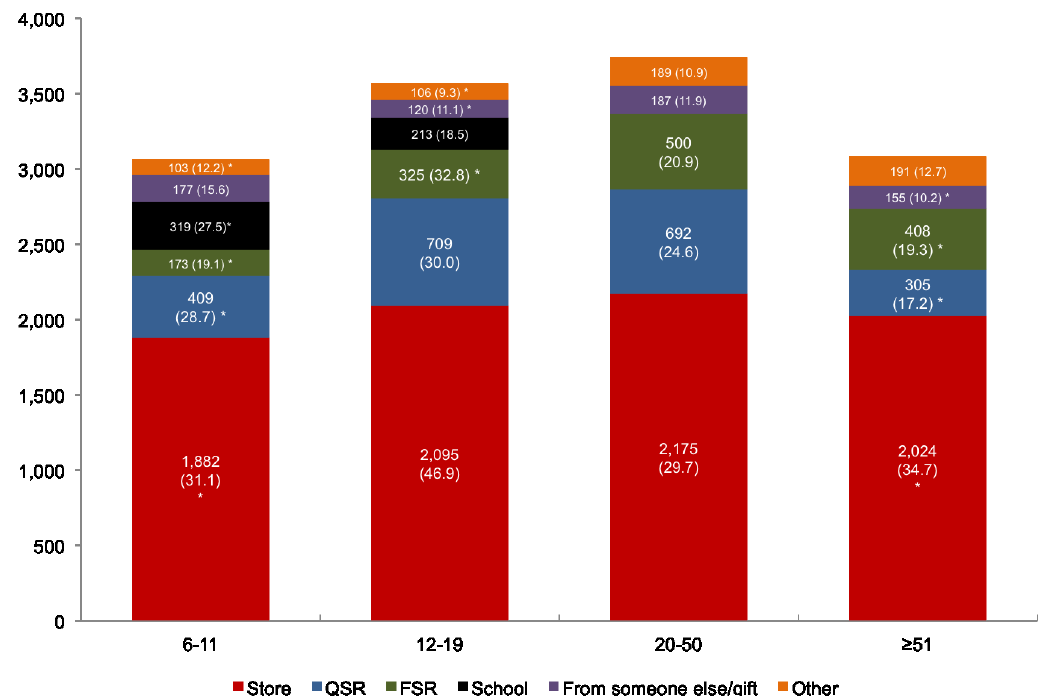
Values in parentheses represent standard errors of the age-adjusted survey-weighted mean. Asterisk (*) indicates value significantly different than value observed for 20–50 year age group. Figure 2. Location of dietary sodium (mg) by race/ethnicity among adults (age ≥20 years), NHANES 2003–2008.